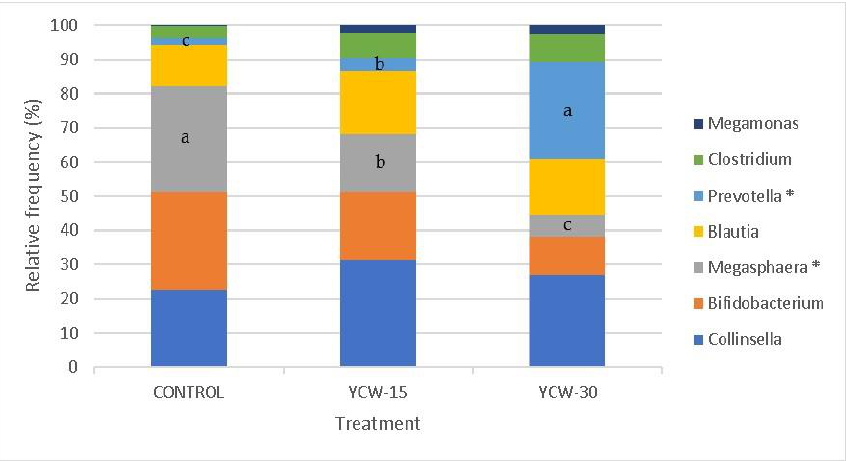
Figure 4. Relative frequency variation of the main fecal bacterial classes in control, YCW-15, and YCW- 30 groups. a,b,c Boxes with the same letters are similar at p ≤ 0.0015. * Classes with significant differences.